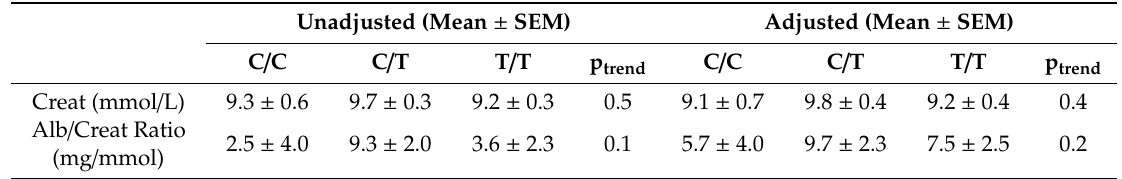
Table 4. TRPV1 -rs8065080 and urine creatinine and albumin to creatinine